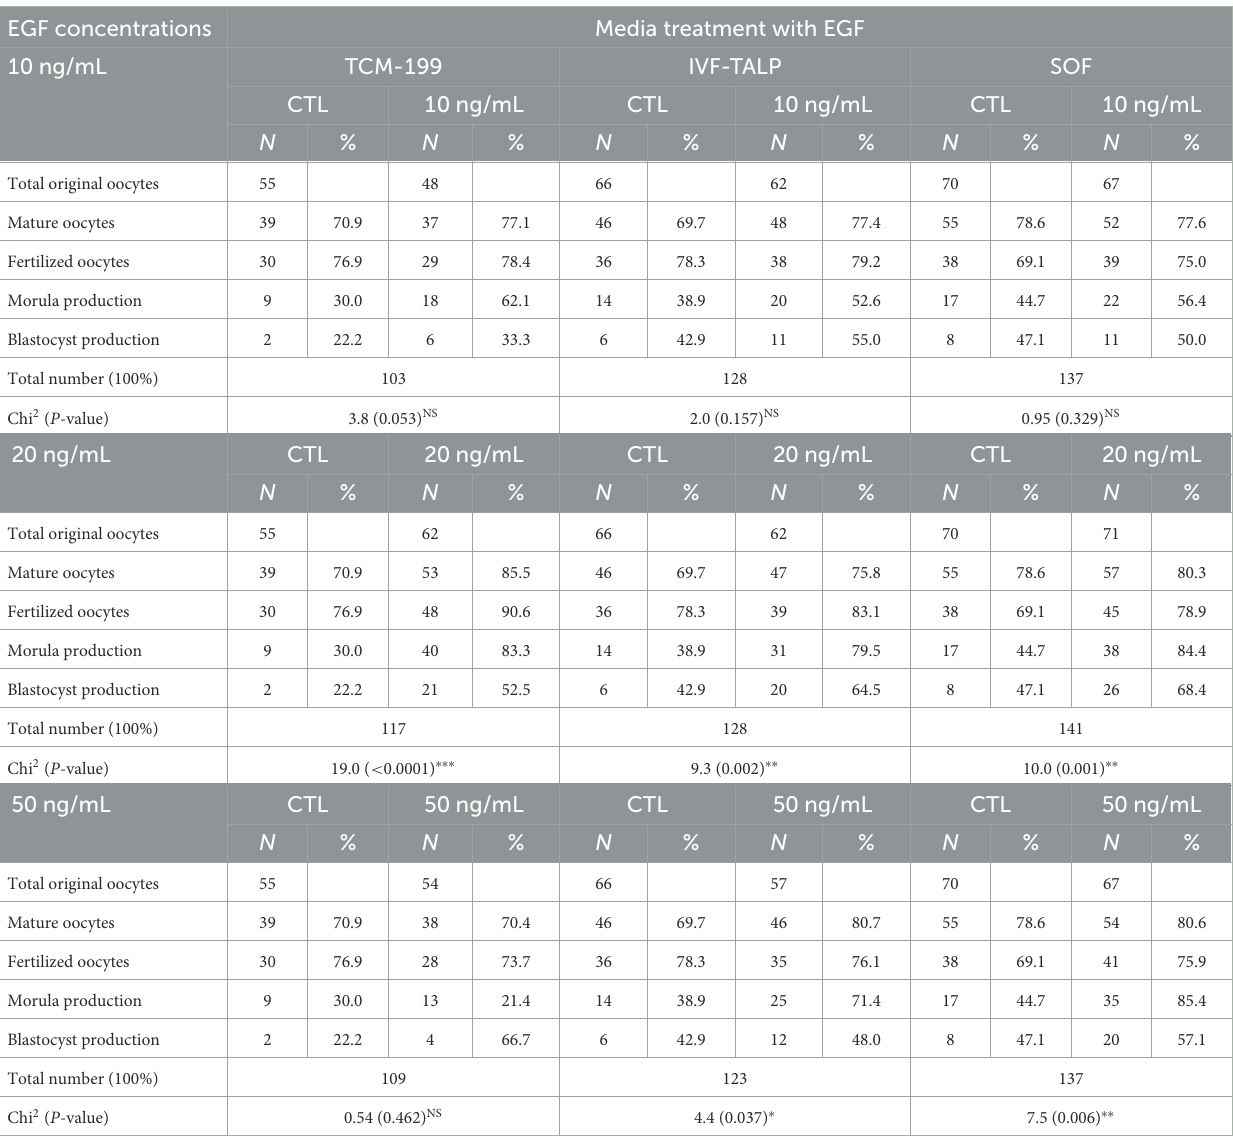
TABLE 1 Effects of epidermal growth factor (EGF) added to maturation (TCM-199), fertilization, (IVF-TALP), and culture (SOF) media on the embryo stages in buffaloes; oocyte maturation, fertilization, cleavage/morula and blastocyst